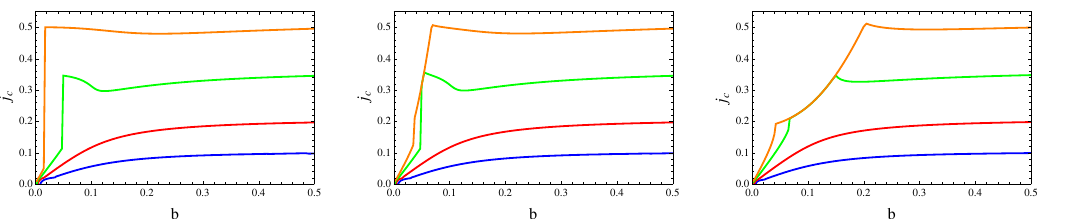
Figure 4 . The parameter j ( v c ) = j c characterising the ground state as a function of the magnetic 0 (cid:12)eld b for four di(cid:11)erent values of the chemical potential (cid:22) = 0 : 2 (blue), (cid:22) = 0 : 4 (red), (cid:22) = 0 : 7 (green) and (cid:22) = 1 (orange). The left, center and right panels correspond to v T = 0, v T = 0 : 1 and v T = 0 : 3,